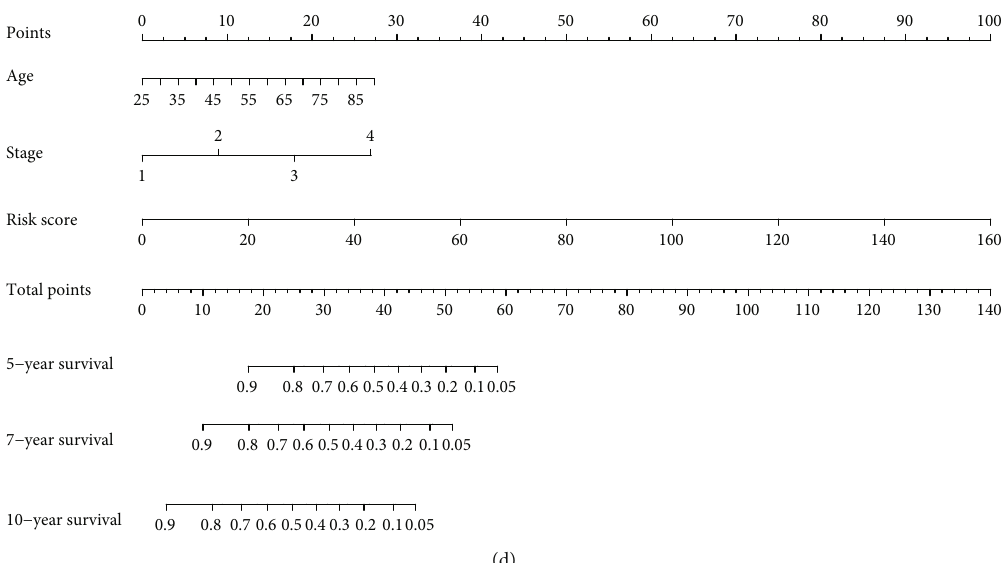
Figure 4: The comprehensive analysis is based on the clinical information of BRCA patients. (a) The heat map shows the correlation between the risk model and the clinicopathological characteristics of BRCA patients. (b) The forest plot shows the results of univariate Cox analysis. (c) The forest plot shows the results of multivariate Cox analysis. (d) Based on this risk model, draw a nomogram that can predict the 5-, 7-, and 10-year OS of BRCA